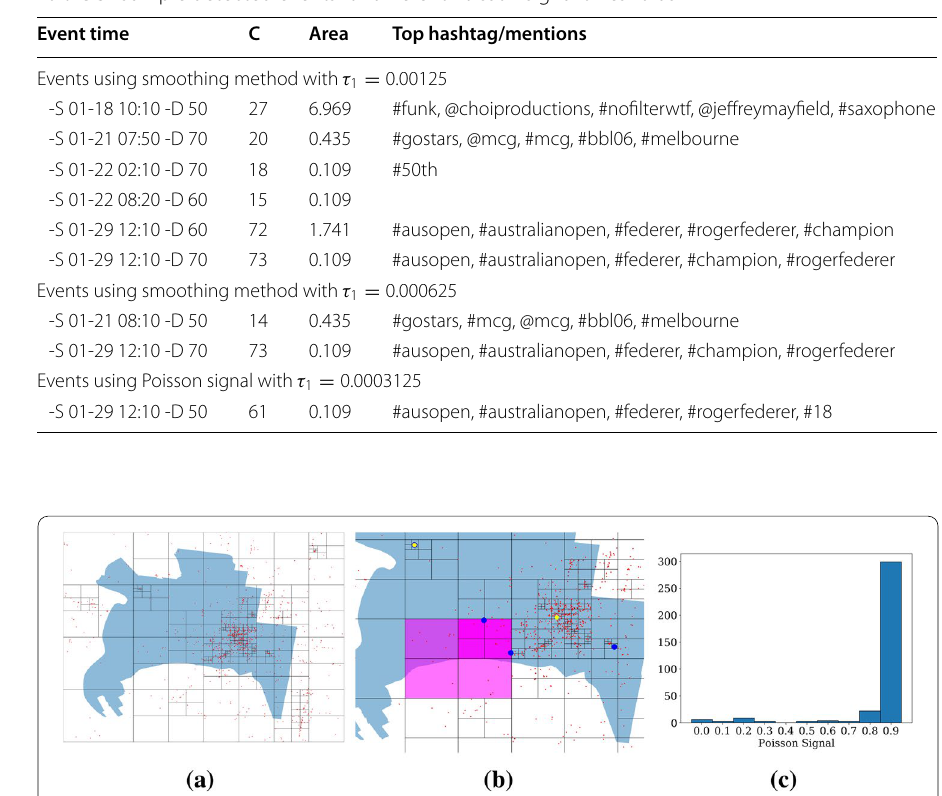
Fig. 2 Event detection results at time-stamp t = 2017 − 01 − 15 7 pm : a Constructed quad-tree using tweets in the interval [ t − T : t ) where T = 3 -days, b Flagged events with Poisson signal, and c Distribution of Poisson signals for all nodes.